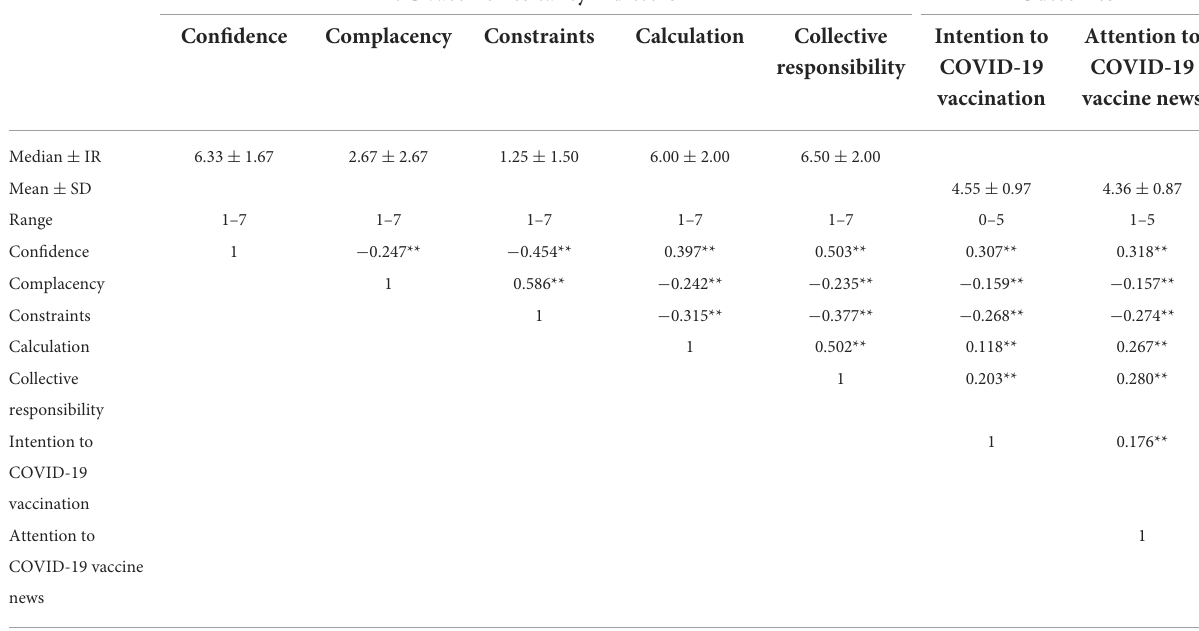
TABLE 2 Correlations of 5C indictors and outcome variables ( N = 1,928).